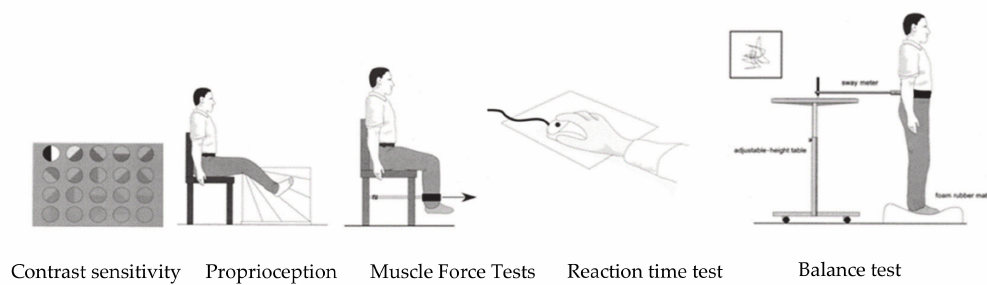
Figure 2. Physiological Profile Assessment (PPA) for fall risk scores template modified from